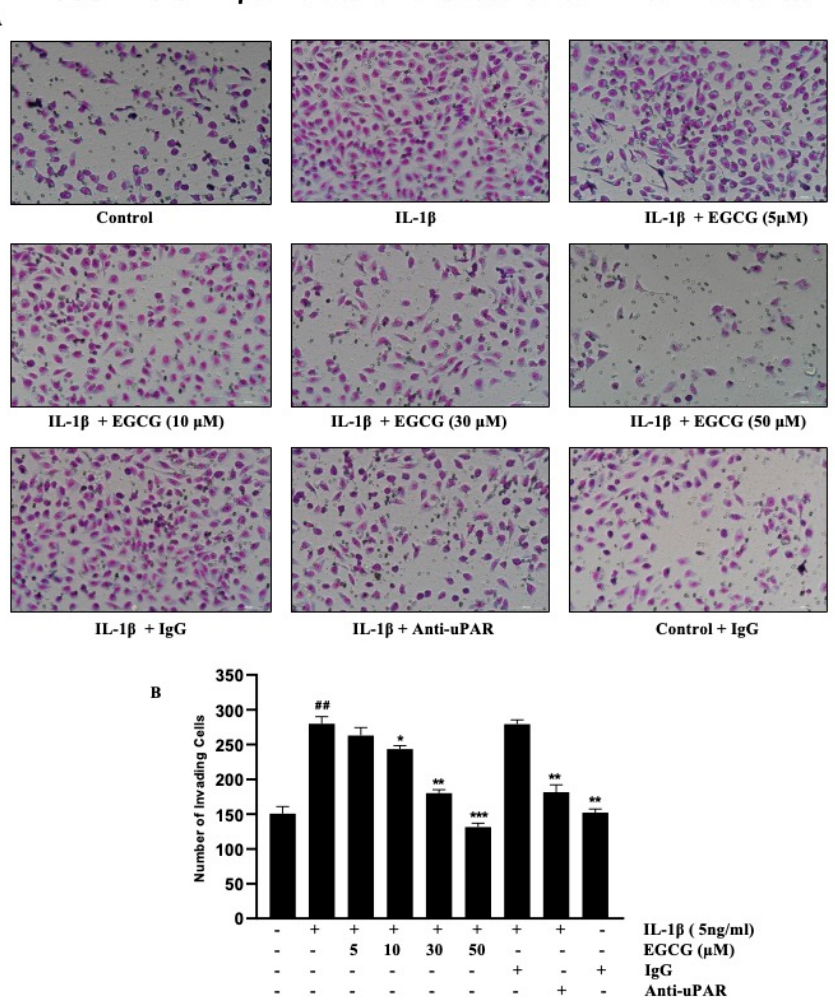
Figure 7. EGCG inhibits the invasion of T24 cells by suppressing uPAR expression. ( A ) T24 cells were incubated with 5 ng/mL IL-1 β in the presence or absence of EGCG or 200 ng/mL, anti-uPAR antibody in a Matrigel apparatus for 24 h. ( B ) The cells were incubated with 5 ng/mL IL-1 β in the presence of non-specific IgG (200 ng/mL), anti-uPAR antibody (200 ng/mL), and 5–50 µ M EGCG. After incubation for 24 h, cells invading the undersurface of the chamber membrane were counted using a phase-contrast light microscope (20 × ) by staining with Diff-Quick stain. ( ## p < 0.01 versus control; * p < 0.05, ** p < 0.01, *** p < 0.001 versus IL-1 β